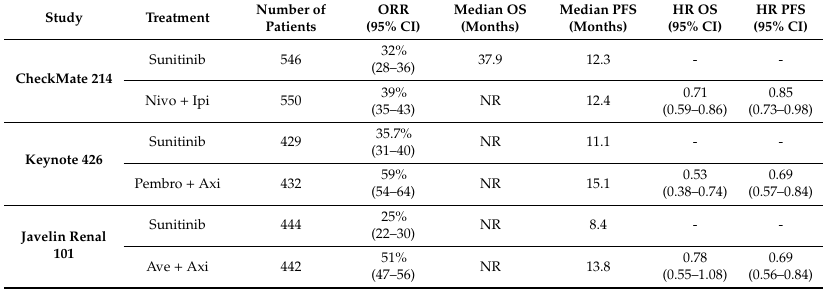
Table 1. Outcomes reported in each trial of the network. Ave: avelumab; Axi: axitinib; Ipi: ipilimumab; Nivo: nivolumab; NR: not reached; ORR: objective response rate; OS: overall survival; Pembro: pembrolizumab; PFS: progression-free